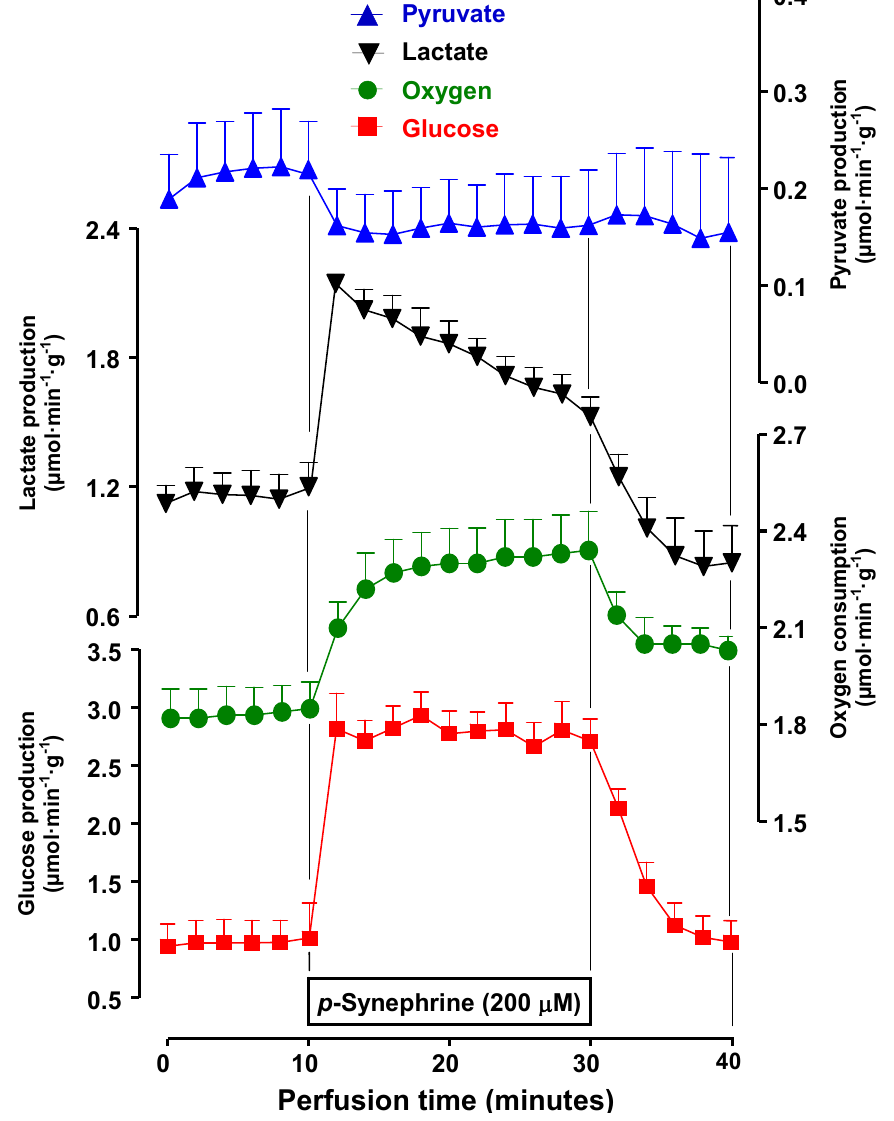
Figure 7. Time courses of the effects of 200 µM p -synephrine on glycogen catabolism and fatty acid-driven oxygen uptake. Livers from fed rats were perfused as described in the Experimental Section. p -Synephrine (200 µM) was infused during 20 min, as indicated. The ef fl uent perfusate was sampled in 2-min intervals and analyzed for glucose, lactate and pyruvate. Oxygen consumption was followed polarographically. Each datum point represents the means of three liver perfusion experiments. Bars are standard errors of the